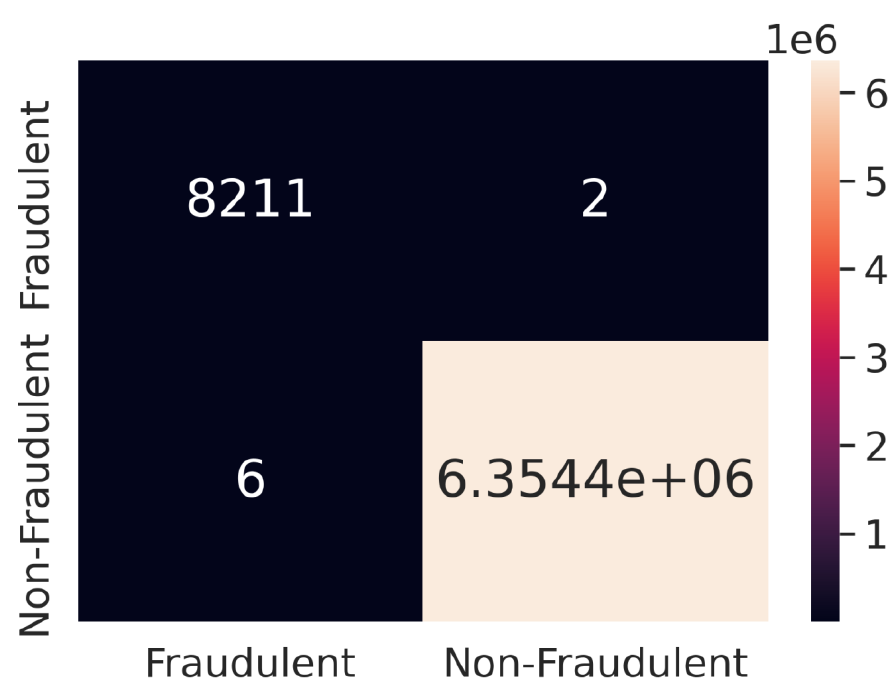
Figure 6. Confusion Matrix for Original Dataset on Final Model.